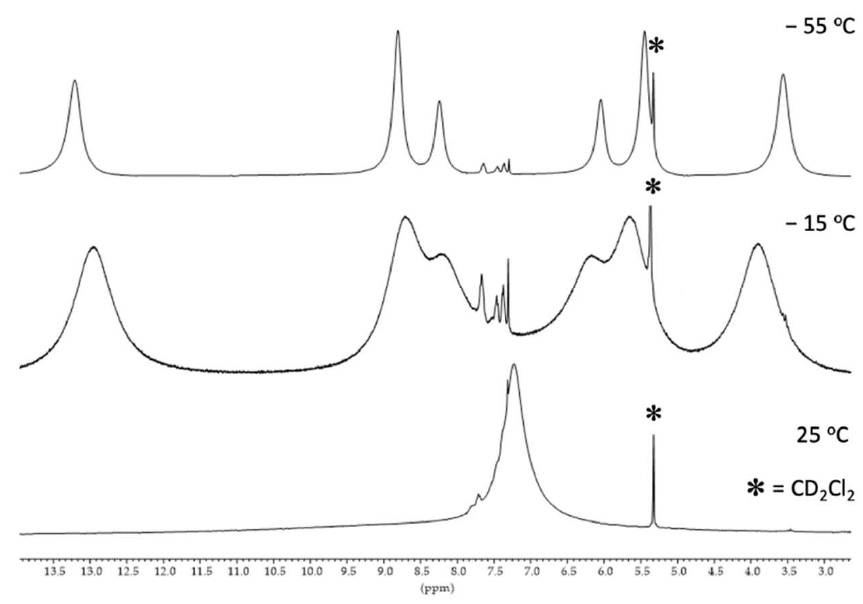
Figure 3. Variable temperature (VT) 1 H NMR spectrum of complex 1 showing aromatic region only, at 25, −15 and −55 °C in CD 2 Cl 2 . Full 1 H NMR spectra can be found in the ESI, Figure S7a. The presence of conformers is further supported by close analysis of the solid-state structure. Three six-membered YbO 2 P 2 C metallacycles, present in 1 , exhibit a combination of boat and twist-boat conformers within the solid-state (Figures 4 and 5). The torsion angles of the O-P-P-O atoms in the metallacycle are all significantly different for all the three metallacycle rings in both the boat and twist-boat conformations (Table